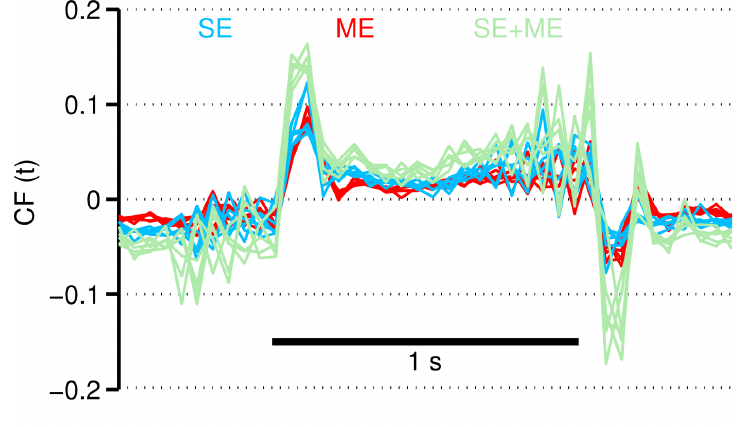
Figure A1. Climbing fiber activity during the control of the DC motor. Five cycles superimposed of the different CF activities during the control of the DC motor with the CNN